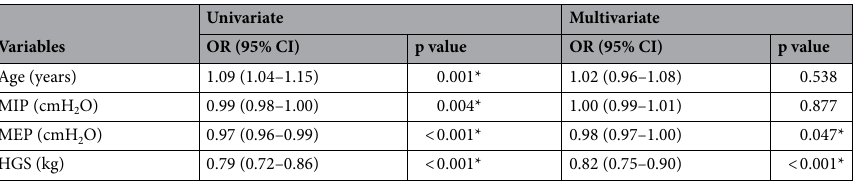
Table 2. Univariate and multivariate logistic regression analysis of sarcopenia. OR odds ratio, 95% CI 95% confidence interval, MIP maximal inspiratory pressure, MEP maximal expiratory pressure, HGS handgrip strength. *p < 0.05. Univariate: univariate logistic regression analyses for the association between age, MIP, MEP, HGS, and sarcopenia. Multivariate: multivariate logistic regression analyses to test whether the MIP, MEP, and HGS are independently associated with